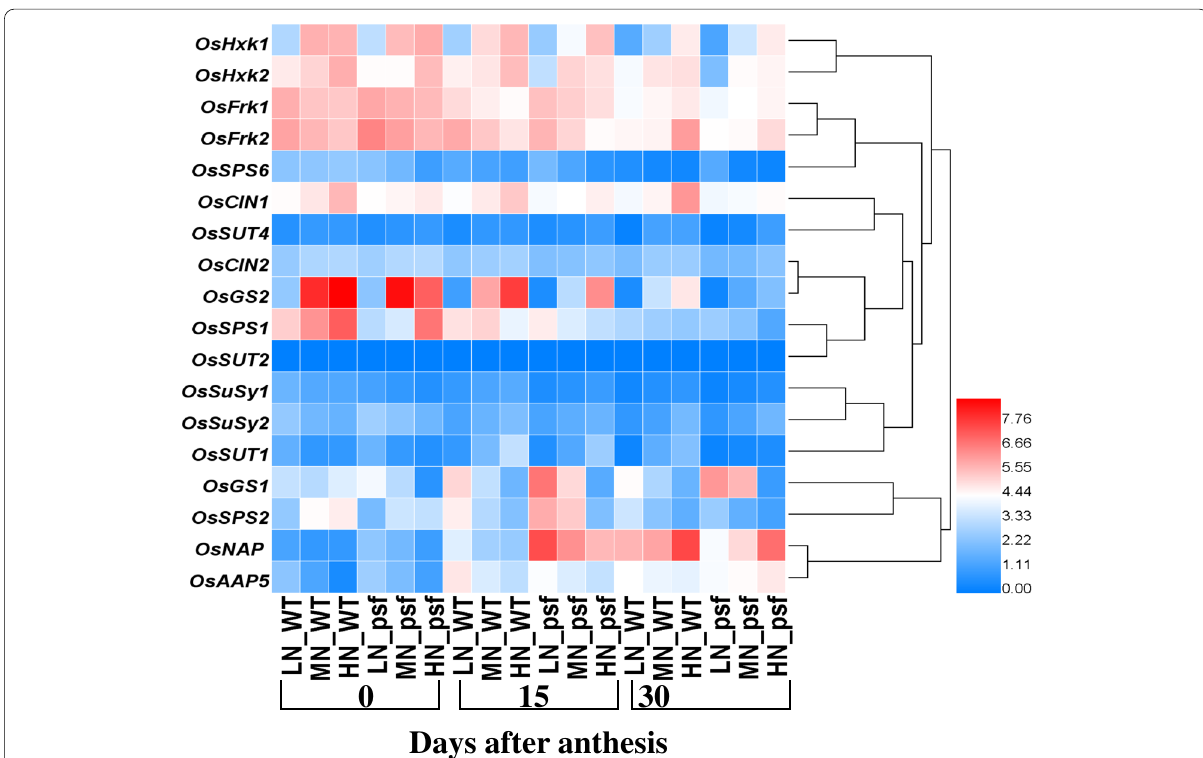
Fig. 4 Expression profiles and temporal pattern of some key genes related to carbon and nitrogen assimilation as heat map; the expression of 18 genes was a profile in the flag leaves of psf and wildtype imposed to different N levels, at different three stages of grain